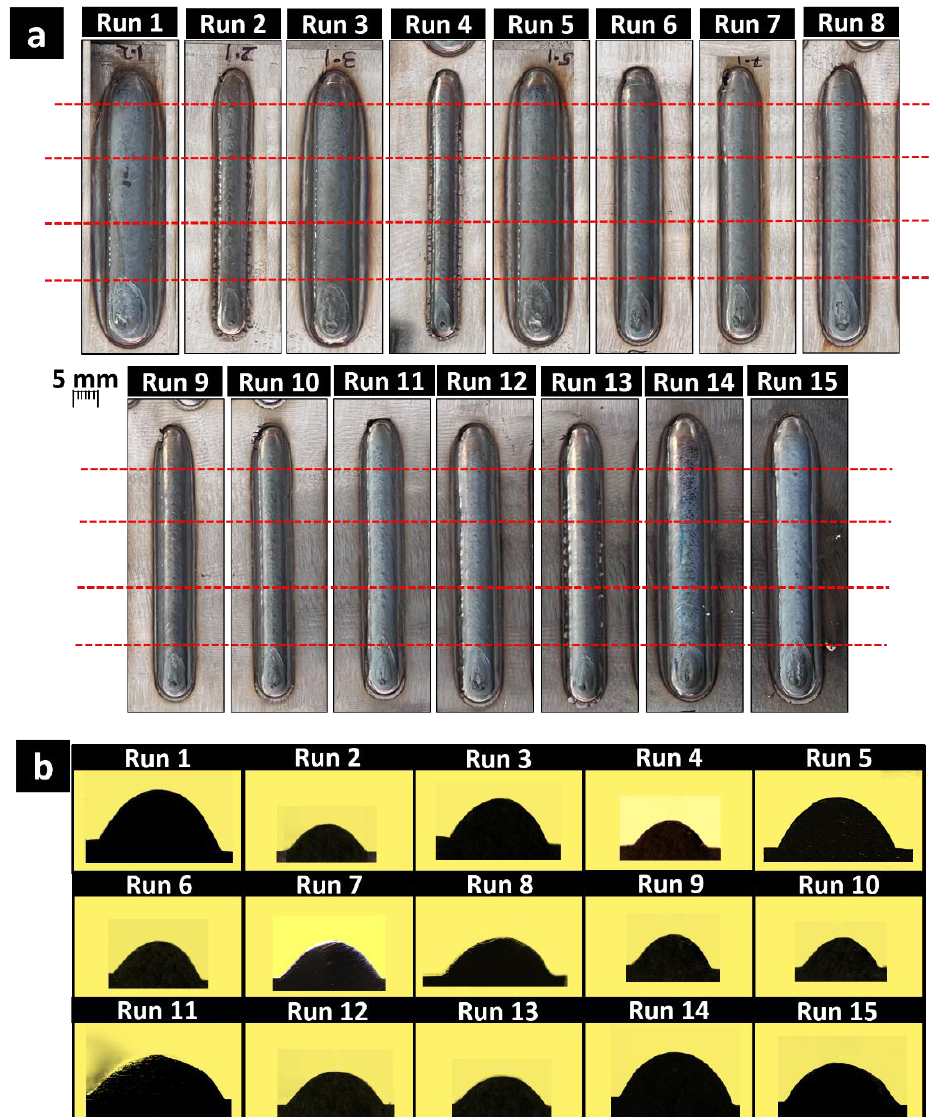
Figure 4. The formation of ( a ) 15 single beads and their ( b ) cross-section made according to runs given by Box – Behnken design using CMT-based WAAM